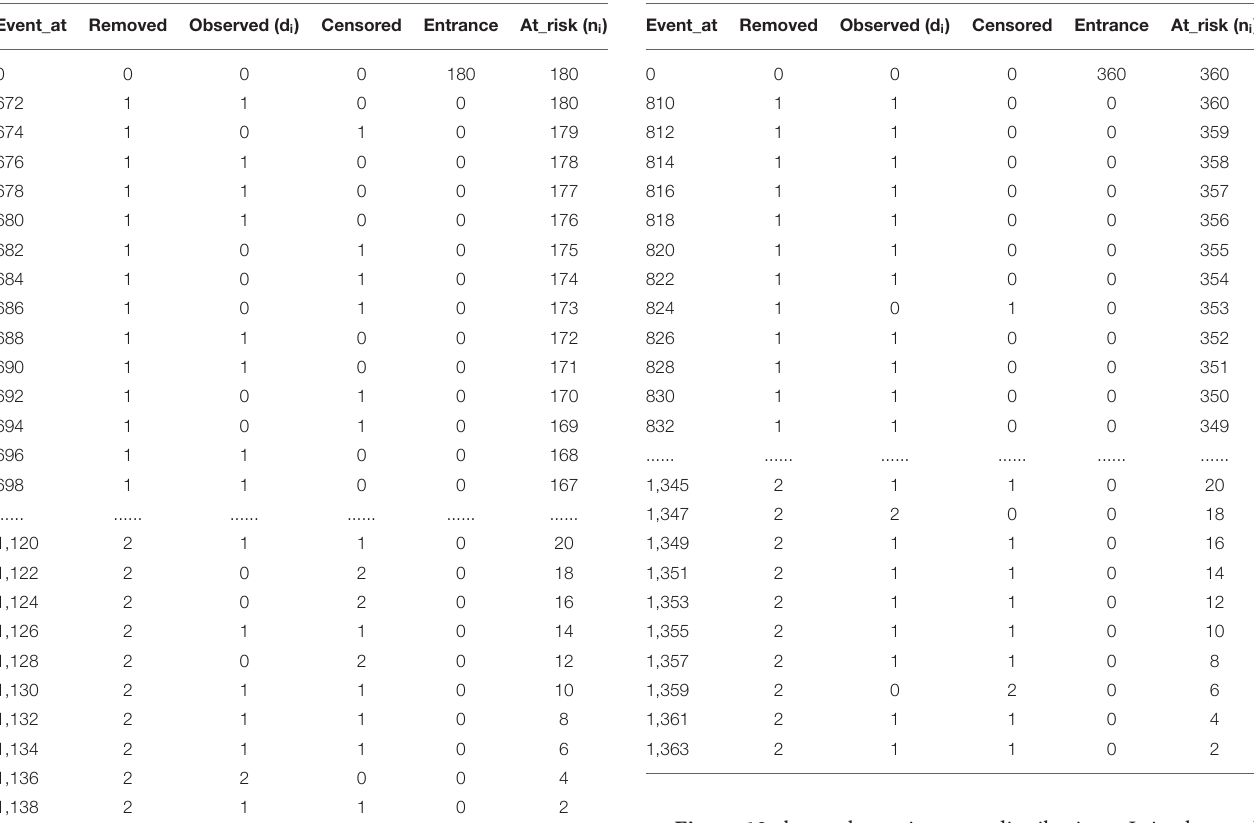
TABLE 16 | Event table for